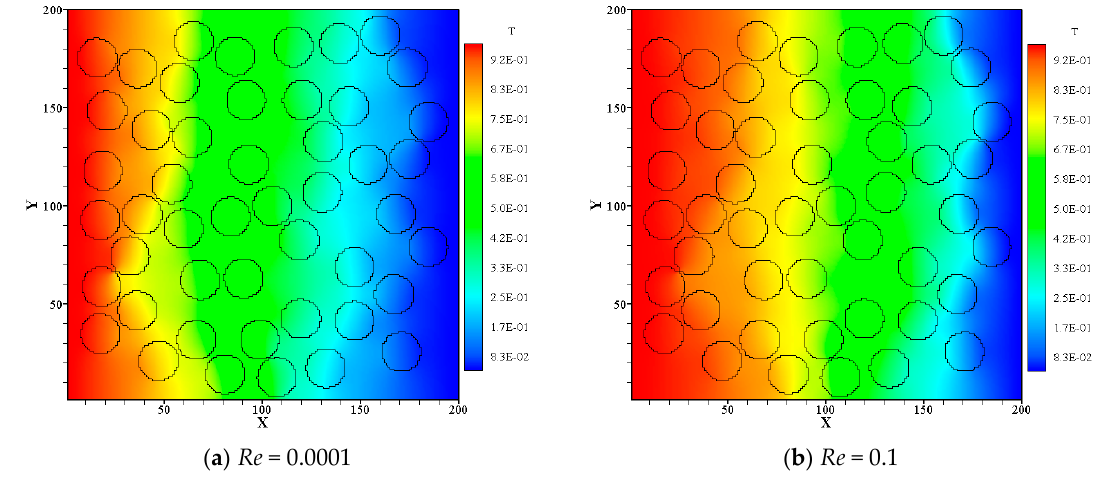
Figure 24. Temperature field nephogram of random structure with different Reynolds numbers.